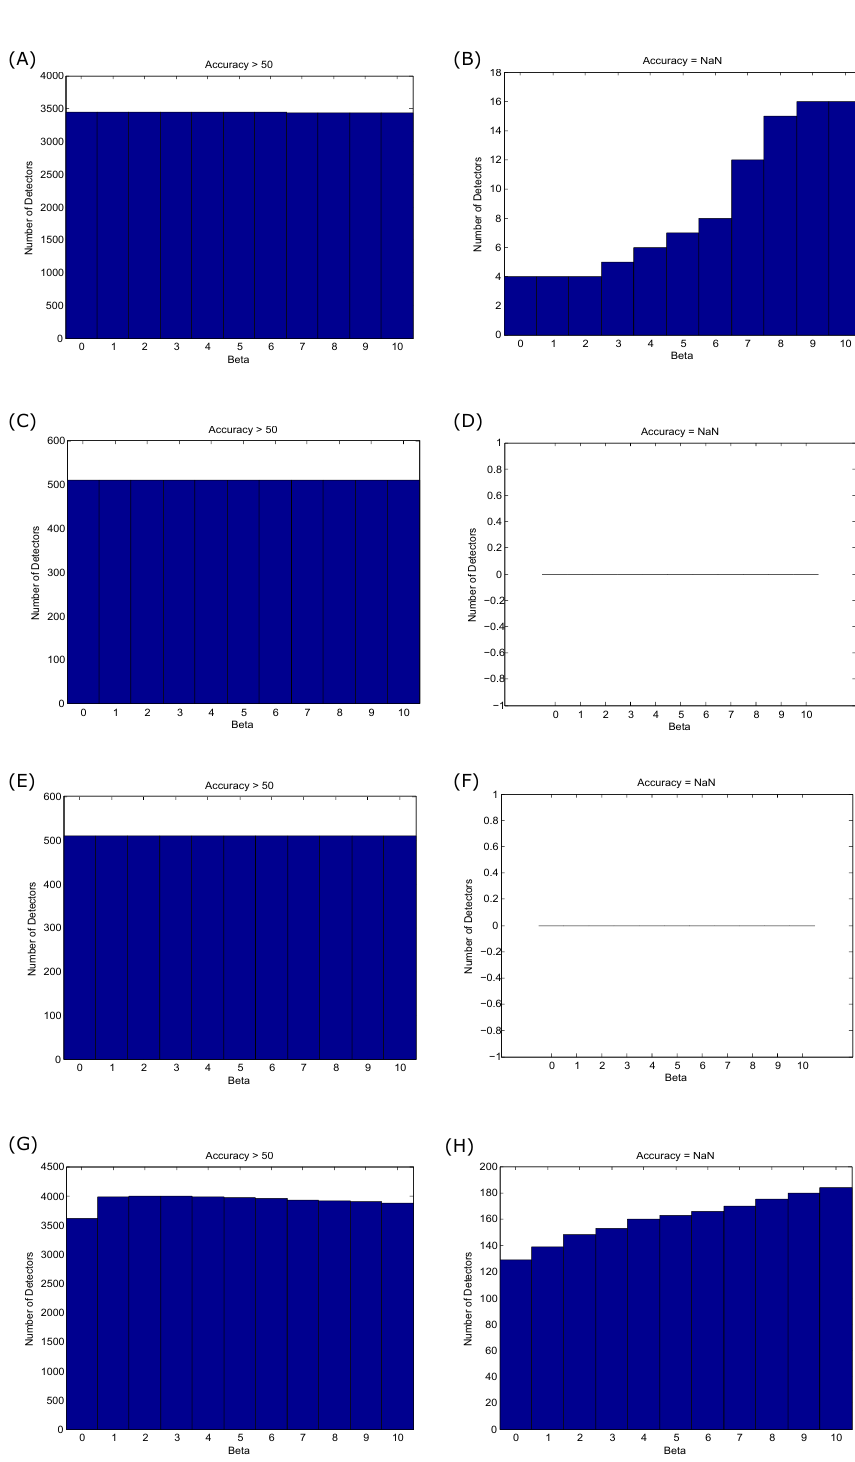
Figure 6. Influence of the offset ( β ) on the generation of blocks of interest on overall accuracy. ( A , B ) QRS detection; ( C , D ) systolic wave detection; ( E , F ) a wave detection; and ( G , H ) heart sound detection. The impact of the β value on the coupling by scoring >50% accuracy is represented in the left column, while the non-coupling is represented in the right column. The coupling is referred to with accuracy >50%, while non-coupling is referred to with not-a-number